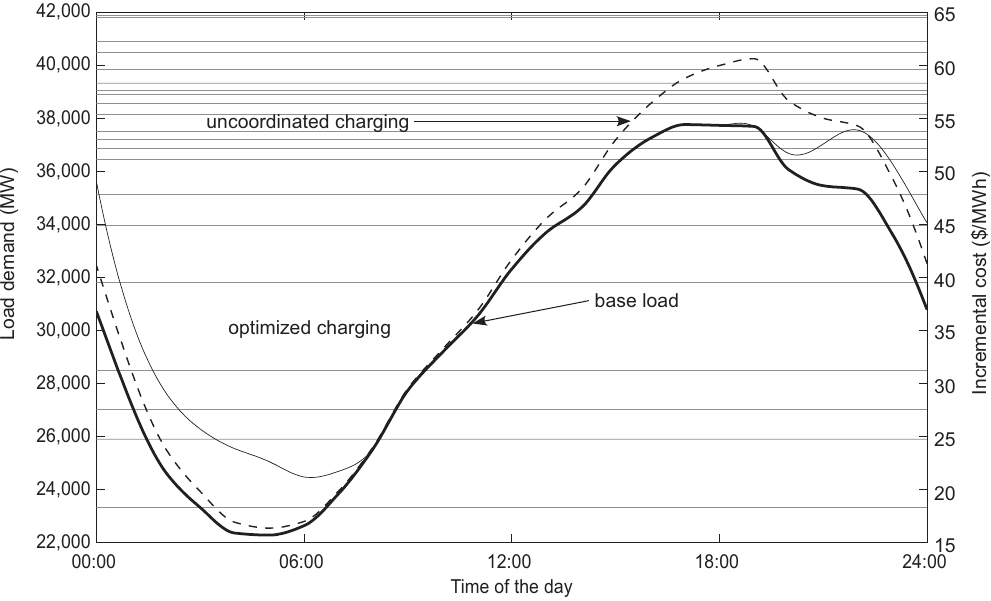
Figure 14. Load demand superimposed on incremental